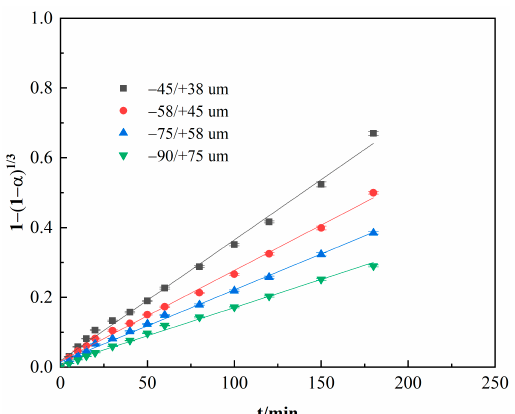
Figure 13. Relationship between 1 − (1 − α ) 1/3 and t at different mineral particle sizes.